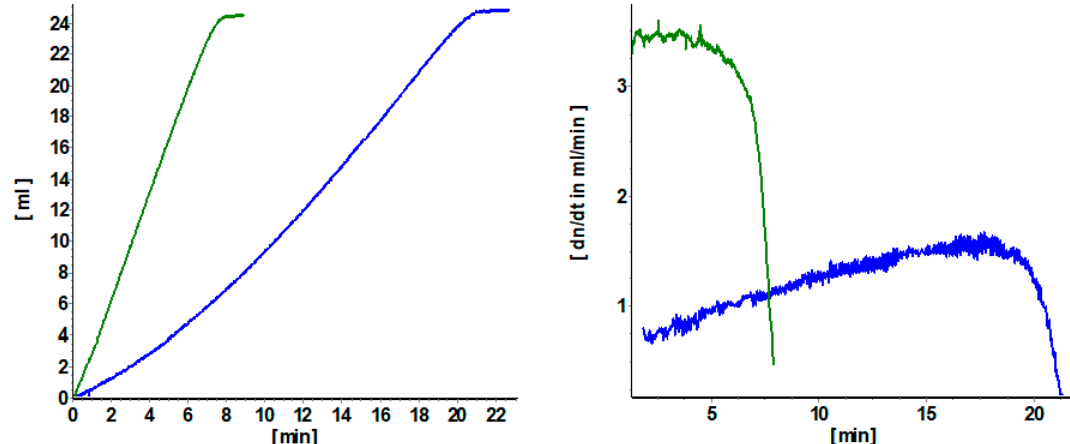
Figure 8. Left: Hydrogen uptake (ml) as a function of time (min) in the hydrogenation of mac with [Rh(( R , R )-Et-ButiPhane)(COD)]BF 4 (99.0% ee, blue) and with [Rh(( R , R )-Et-ButiPhane)(MeOH) 2 ]BF 4 (99.0% ee, green) under standard conditions [92]. Right: moles of hydrogen consumed per unit time (dn / dt) as a function of time (min) in the hydrogenation of mac with [Rh(( R , R )-Et-ButiPhane)(COD)]BF 4 (blue) and [Rh(( R , R )-Et-ButiPhane)(MeOH) 2 ]BF 4 (green).